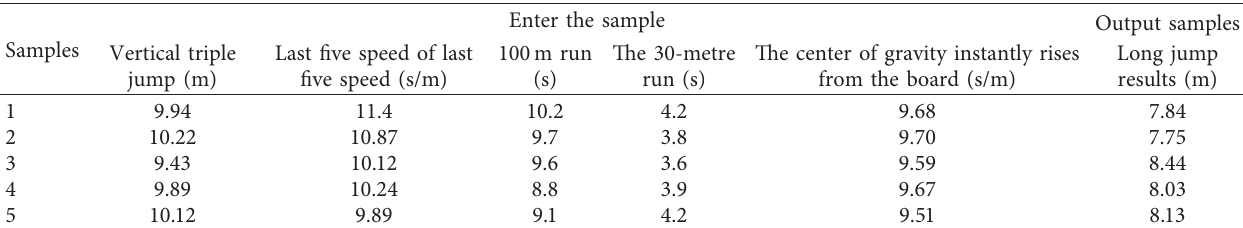
Table 2: CAD assisted in intelligent analysis of input and output layer data.